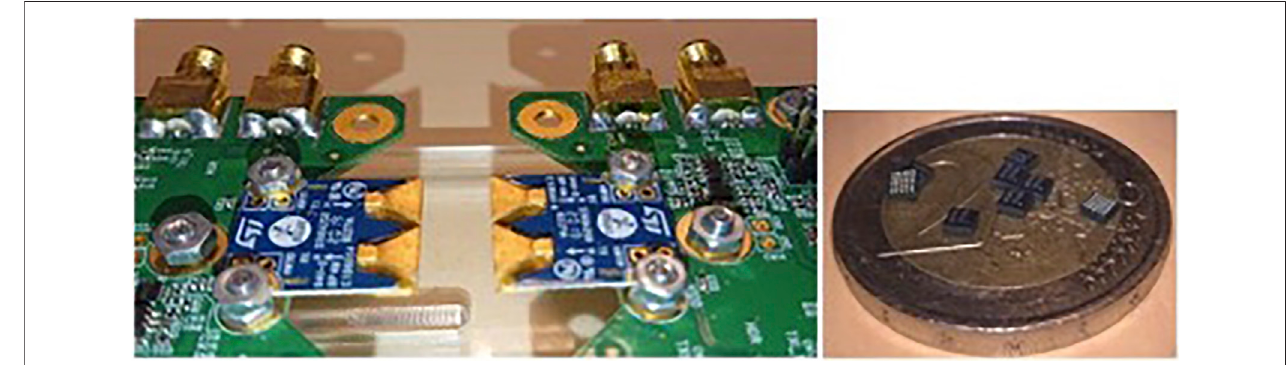
FIGURE 2 | ST Microelecronics ST60 contactless connectivity transceiver in BGA.